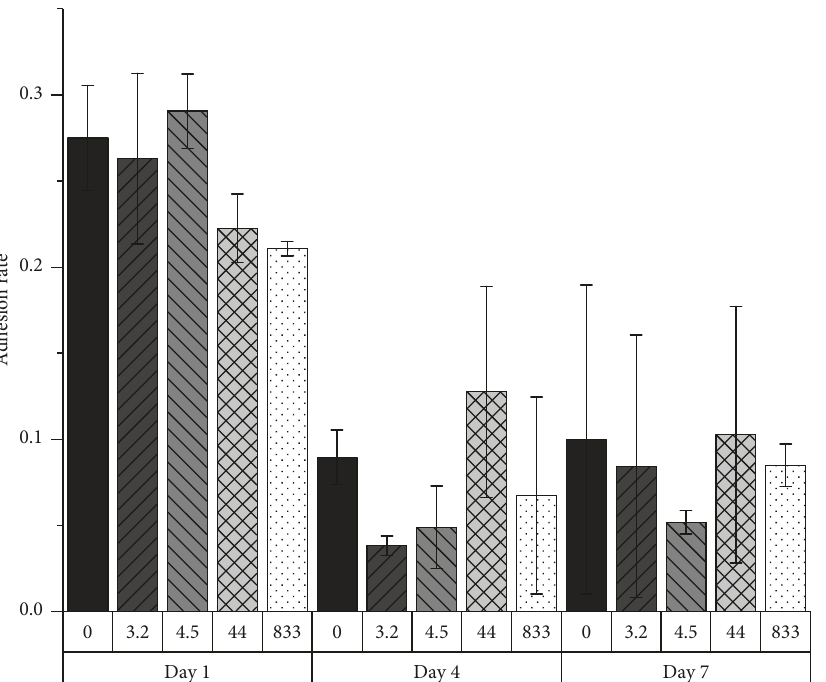
Figure 2: Polyurethane adhesion study of normalized cell attachment on samples ( n � 3, p < 0 . 05, error bars depict standard